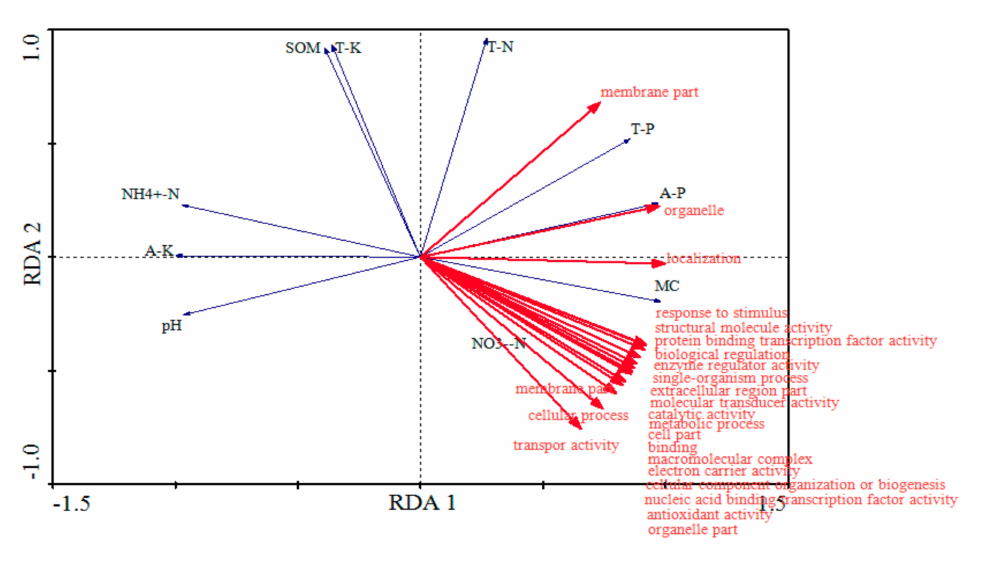
Figure 7. Redundancy analysis (RDA) of soil chemical properties and genes in N cycling, showing the contribution of environmental parameters to variability. Arrows indicate environmental factors and their relative e ff ects on genes of the N